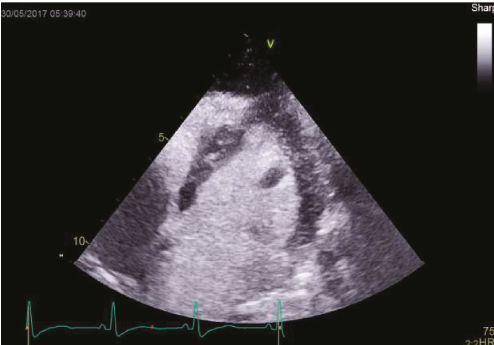
Figure 4: Apical 2 chamber view with agitated saline captured at end systole showing basal and apical ballooning with preserved contractility of the mid ventricular